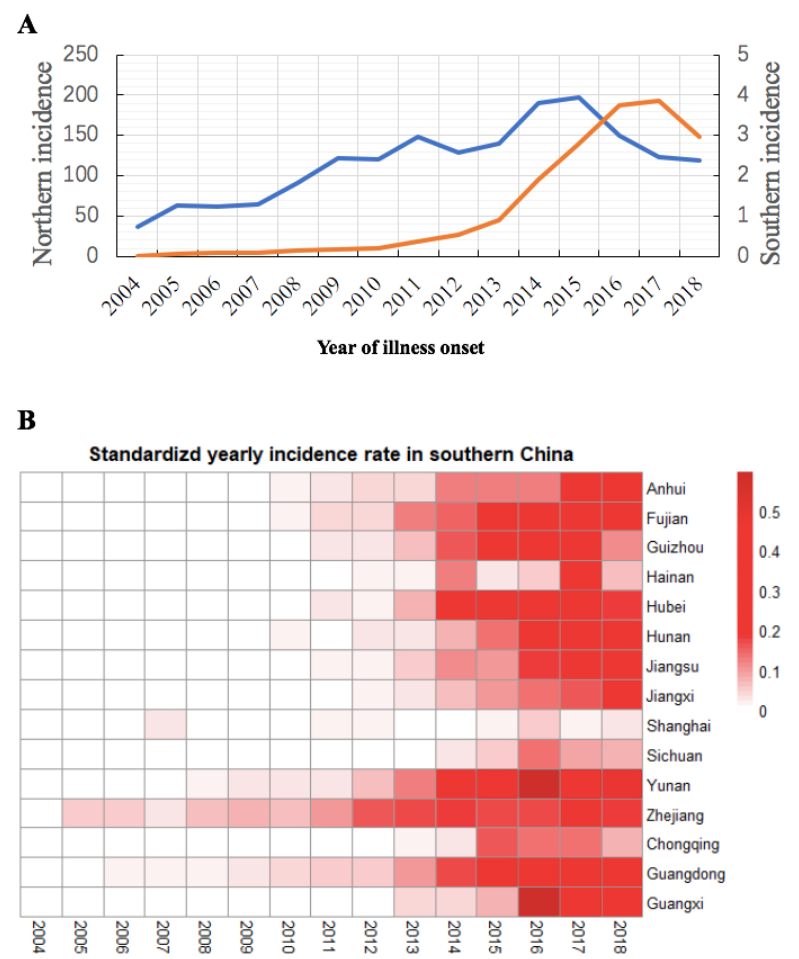
Figure 3. ( A ) The incidence (1 / 100,000) of HB in northern (blue line) and southern (orange line) China from 2004 to 2018. ( B ) Heat map of provinces with HB cases in southern China.